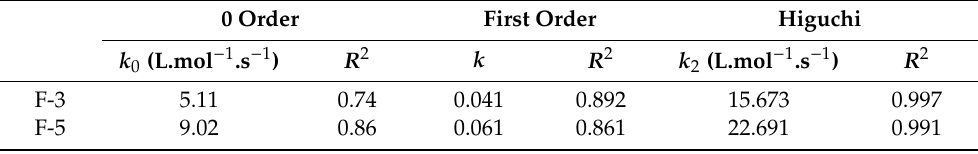
Table 4. Regression coe ffi cients and kinetic constants for various release models.